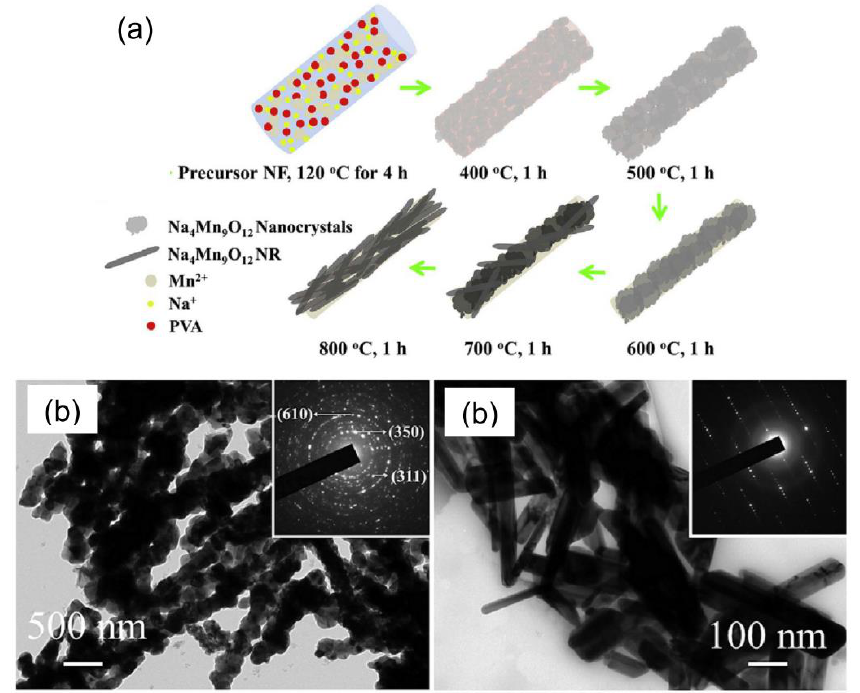
Figure 10. ( a ) Sketch of the shape evolution of the building blocks forming the electrospun Na 0.44 MnO 2 fibers upon the increase of the heat treatment temperature. ( b , c ) TEM images (insets: related SAED patterns) of the fibers obtained at (b) 600 °C and (c) 800 °C (reproduced from reference [124] with patterns) of the fibers obtained at (b) 600 ◦ C and (c) 800 ◦ C (reproduced from reference [124] with permission. Copyright 2016, Elsevier). permission. Copyright 2016,